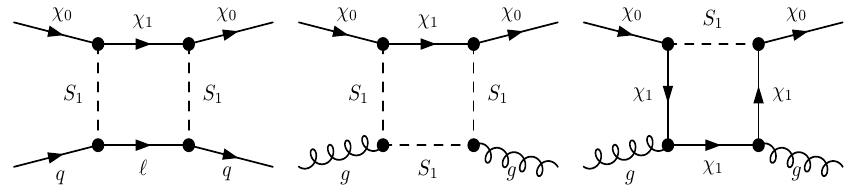
Figure 11 . Representative LO Feynman diagrams relevant for DM direct detection in our